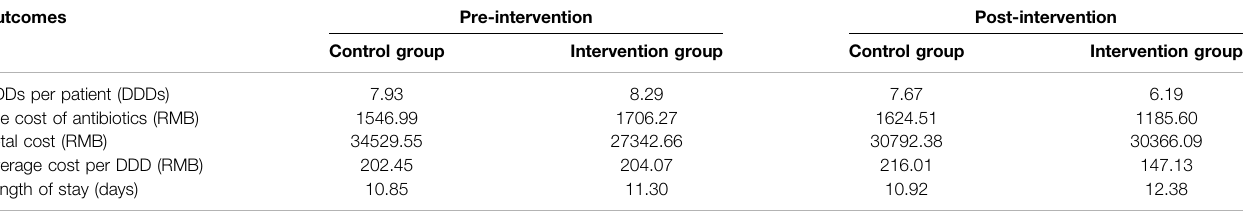
TABLE 2 | The mean antibiotic consumption, costs, and length of hospital stay in the control and intervention groups between the pre-intervention and post-intervention periods. Outcomes